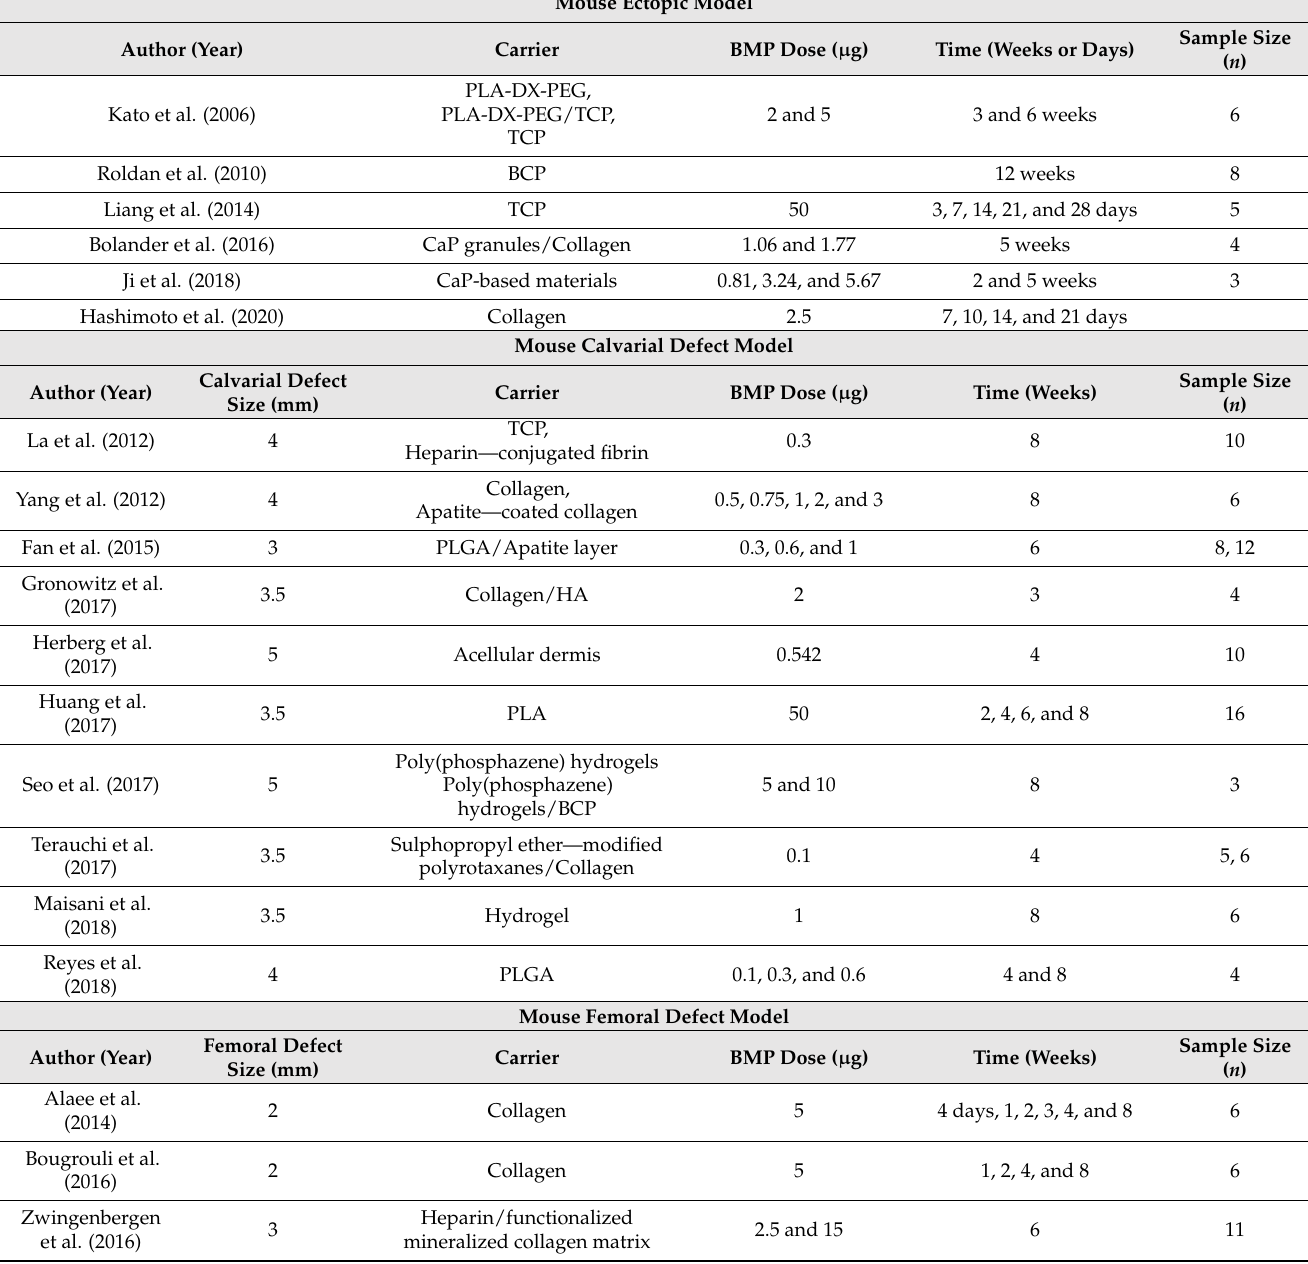
Table 1. Mouse ectopic and bone defect